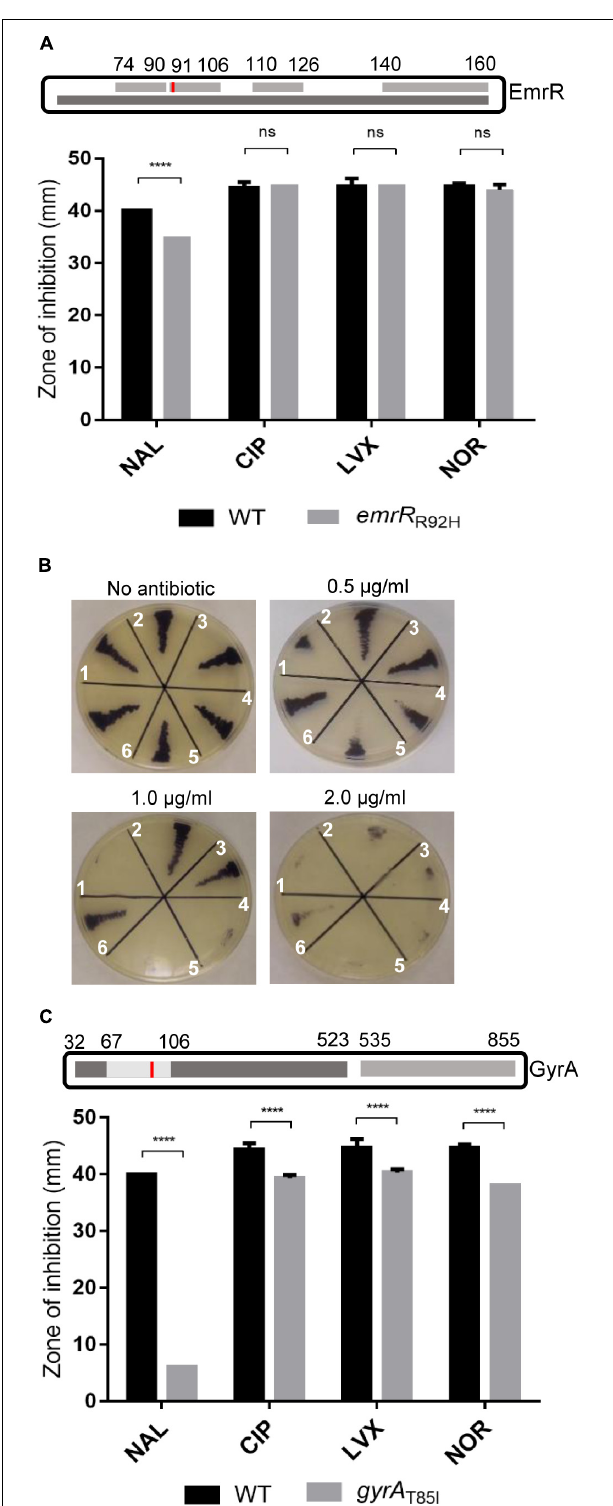
( Figures 7D,E ) and presented decreased biofilm formation ( Figure 7F ), suggesting that overexpression of EmrCAB decreases the intracellular accumulation of AHLs and of nalidixic (Continued)